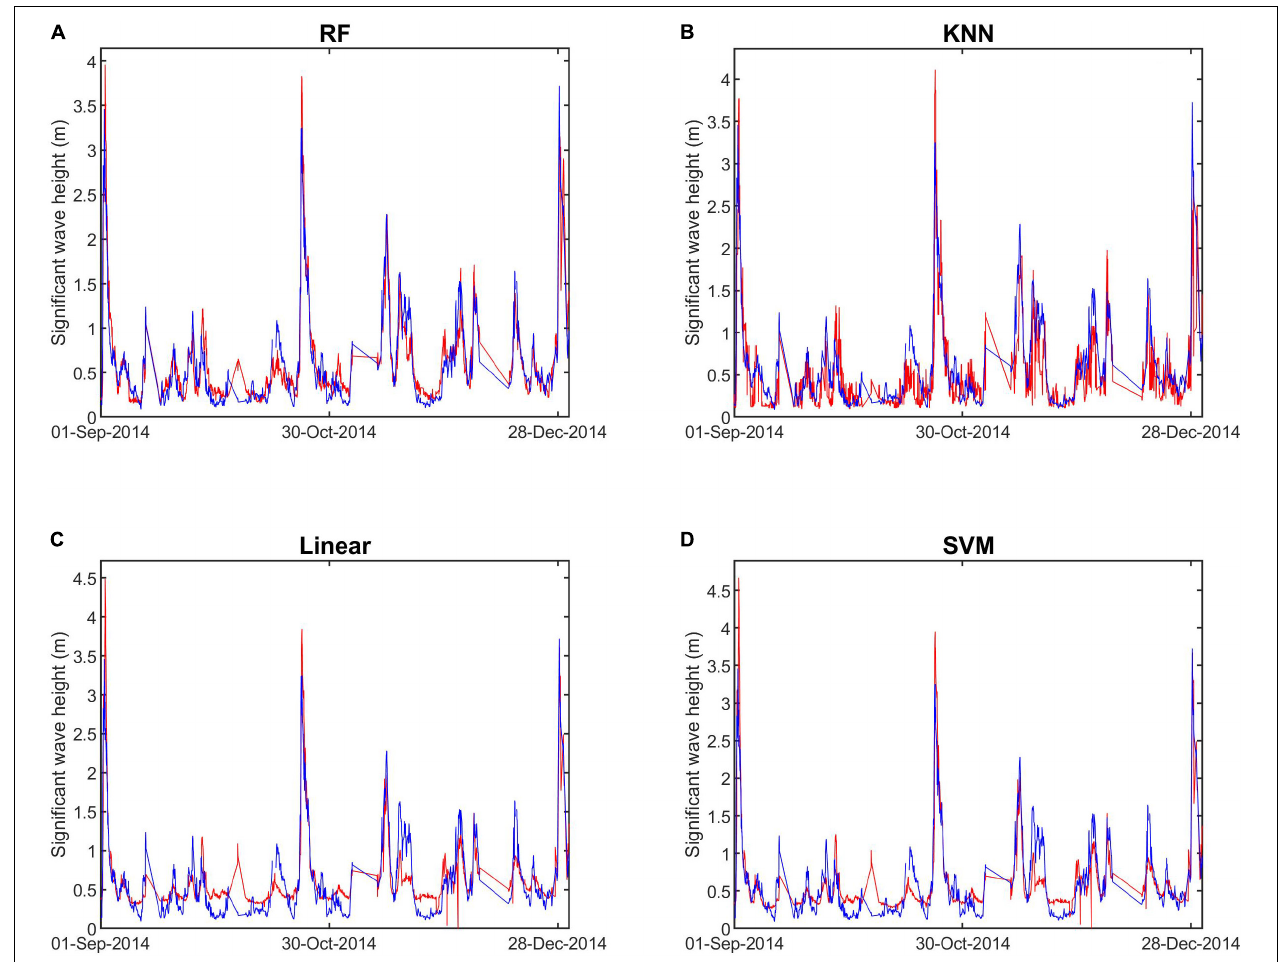
FIGURE 12 | Measured ( blue line ) and predicted ( red line ) significant wave height time series of the Cetraro buoy from 1 September to 31 December 2014. The prediction was carried out by RF regression (A) , KNN regression (B) , linear regression (C) , and SVM regression (D)